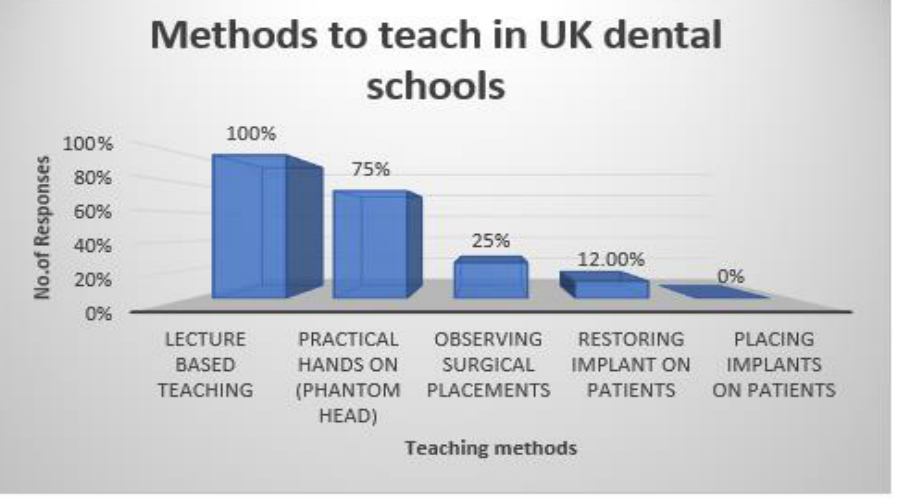
Figure 2. Percentage of teaching methods adopted by the dental schools of the UK.